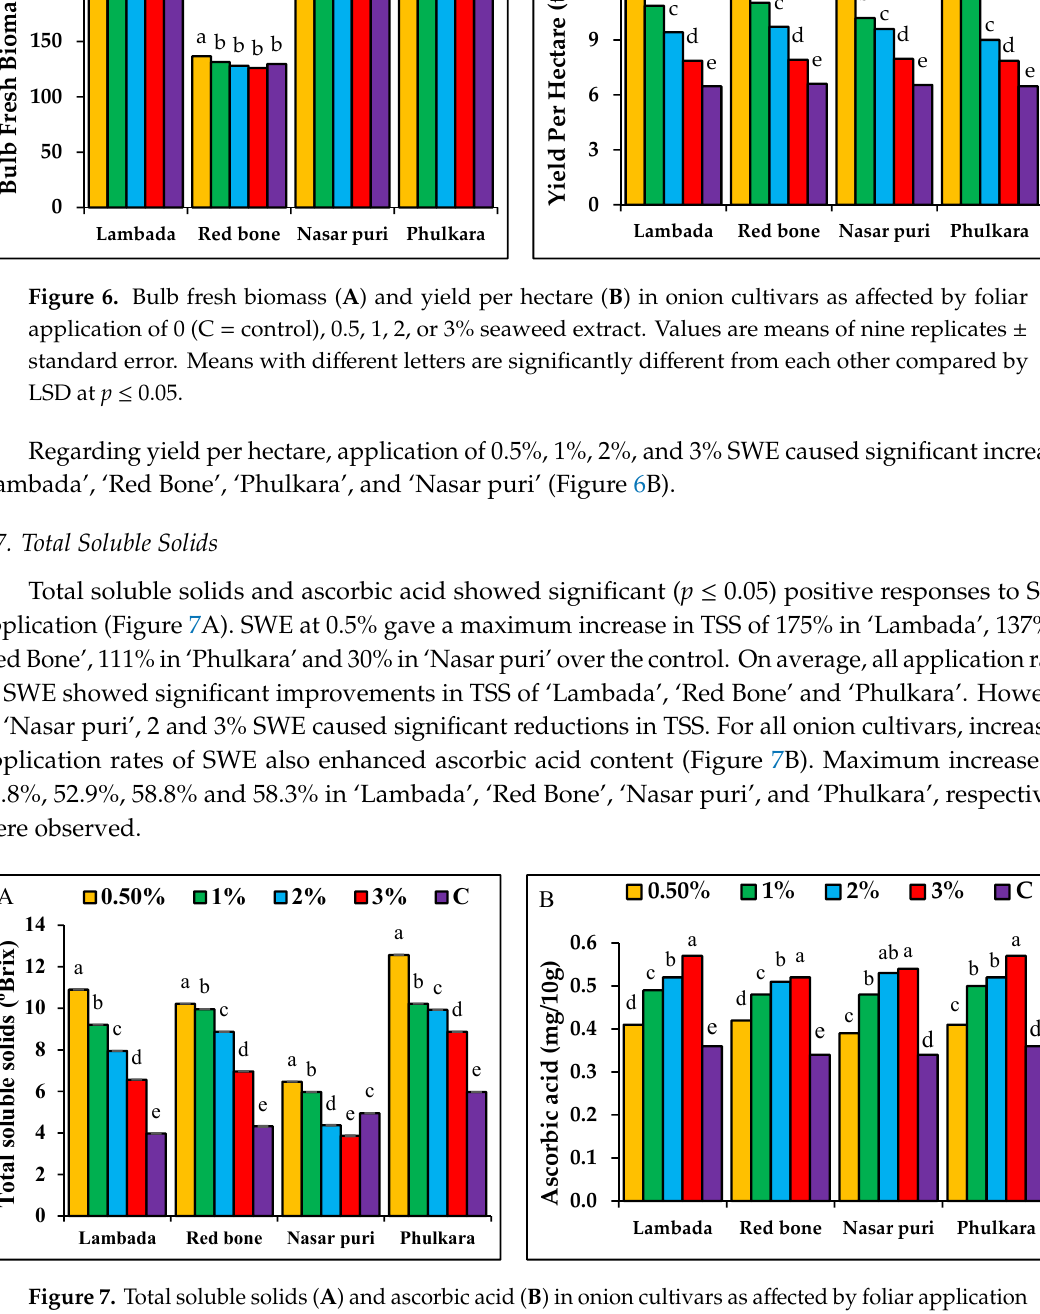
Figure 7. Total soluble solids ( A ) and ascorbic acid ( B ) in onion cultivars as a ff ected by foliar application of 0 (C = control), 0.5, 1, 2, or 3% seaweed extract. Values are means of nine replicates ± standard error. Means with di ff erent letters are significantly di ff erent from each other compared by LSD at p ≤